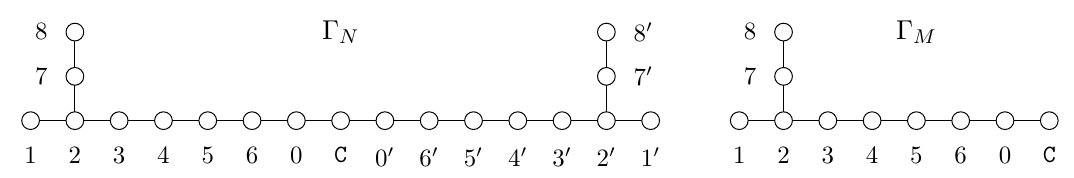
Figure 1 . Generalized Dynkin diagrams for the Narain lattice Γ N ’ Γ 1 , 17 and the Mikhailov lattice Γ M ’ Γ 9 , 1 in nine